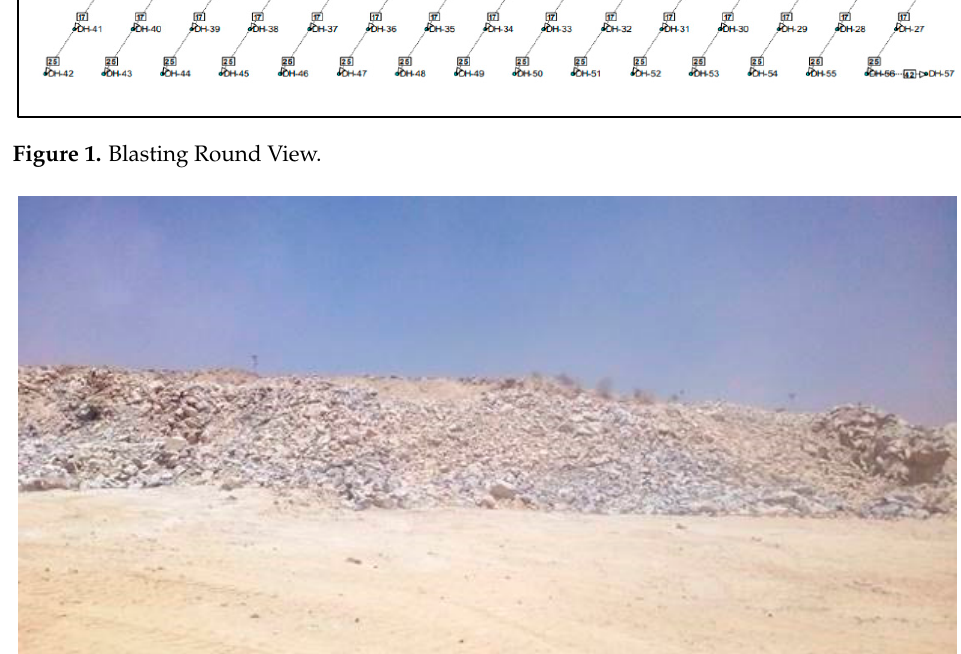
Figure 2. Close-up View of Blasted Limestone at Shree Cement Ras Limestone Mine in India.